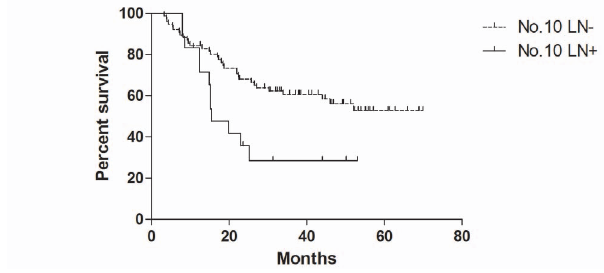
Figure 5. Kaplan-Meier survival analysis of No.10 LNs for patients with histological evidence of LNs structure in No.10 LNs.